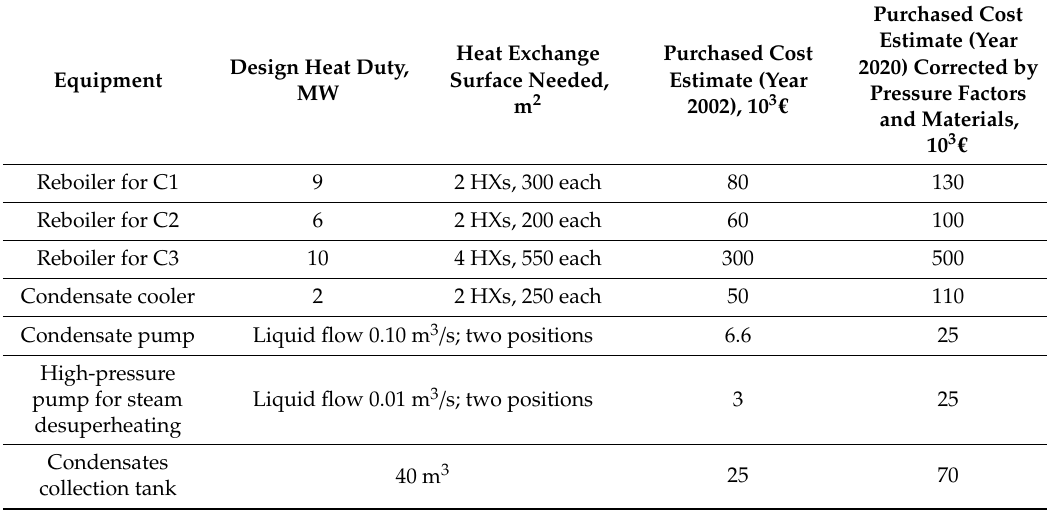
Table 9. Total investment cost estimate based on [48] for scenario